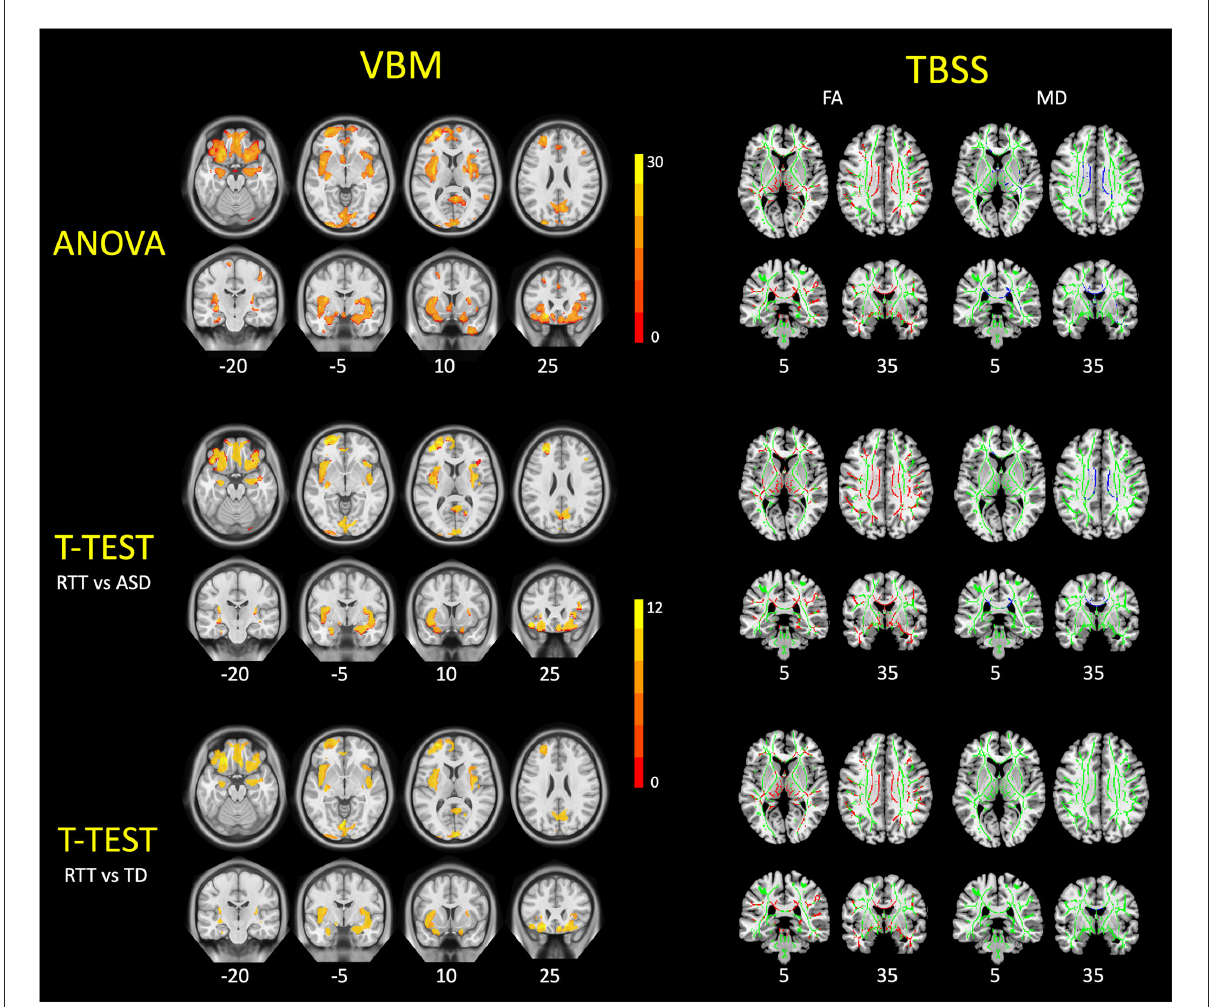
FIGURE3 VBM and TBSS findings in young girls with RTT compared to ASD and TD controls. These figures demonstrated the ANCOVA and post-hoc statistical results of VBM analysis (left) and TBSS analysis (right) among three groups. For VBM results, the RTT group showed significantly decreased gray matter volumes (red-yellow) compared with controls ( p < 0.05, FWE corrected). For TBSS results, TDD group showed significantly decreased FA values (red) and increased MD values (blue) compared with controls ( p < 0.05, FWE corrected). TBSS results are overlaid on the mean FA skeleton